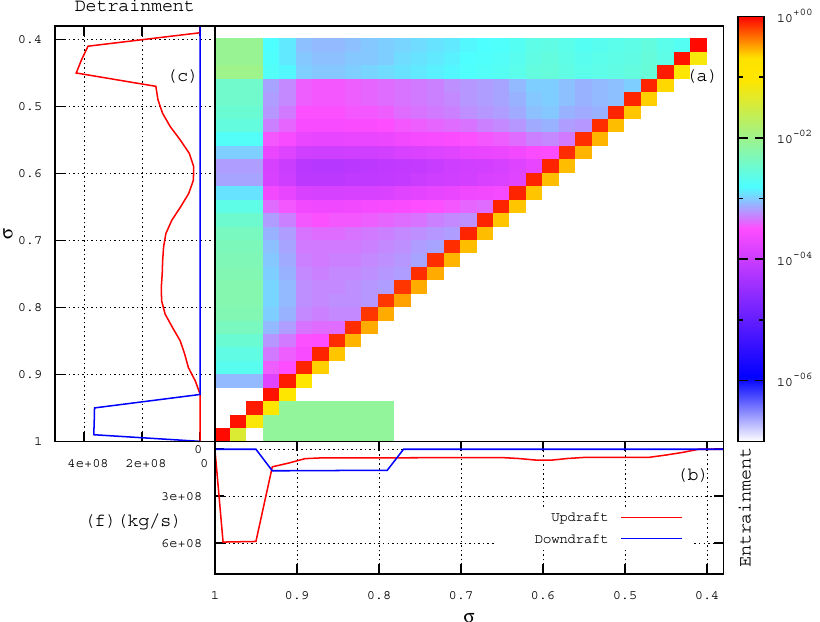
Figure 3. Example of Displacement Probability Matrix (DPM) and the fluxes generated by the convection mechanism, as function of the vertical σ -hybrid coordinate. Panel (a) displays the DPM with origins of displacement in the abscissa and destination in the ordinate. Bottom (b) and left (c) panels display entrainment and detrainment fluxes, respectively, for both updraft (red) and downdraft